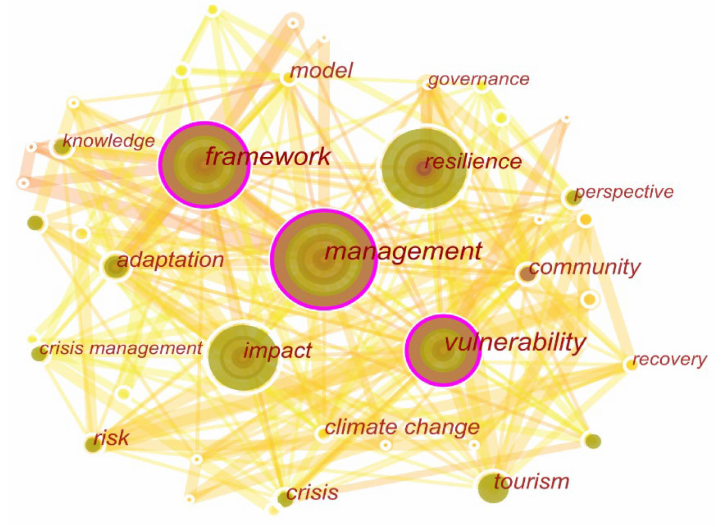
Figure 4. Keywords co-occurrence network during